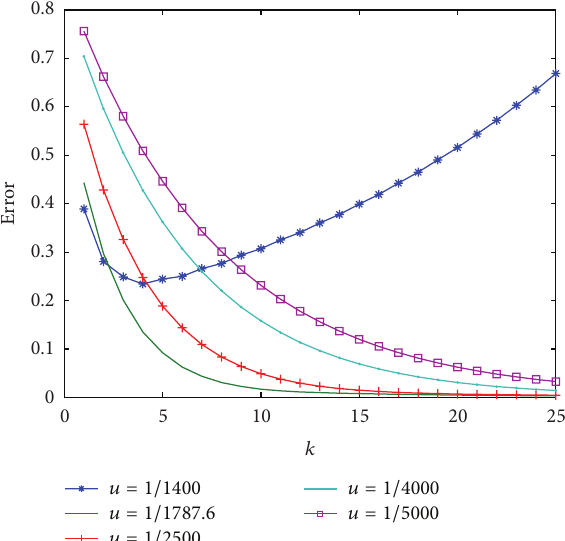
Figure 1: Comparison of convergence curves.